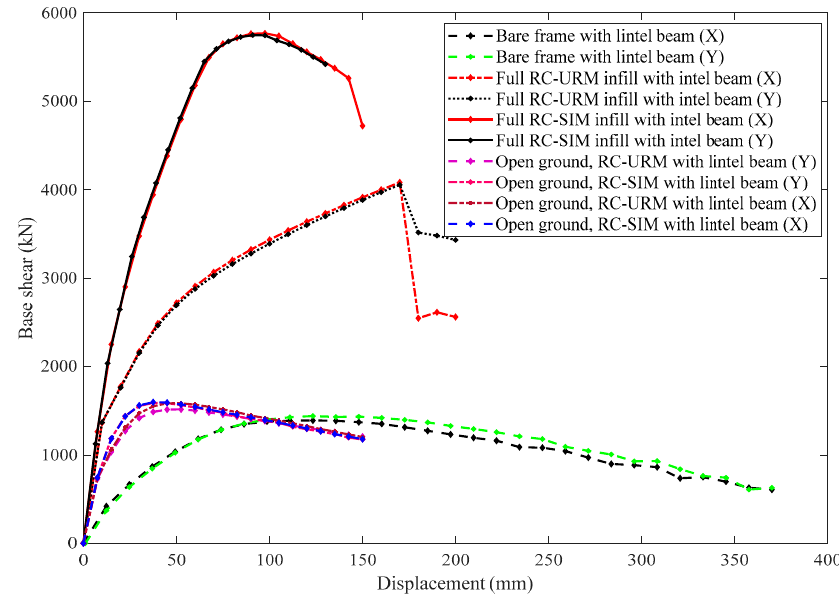
Figure 8. Comparison of pushover curves for various analysis scenarios.